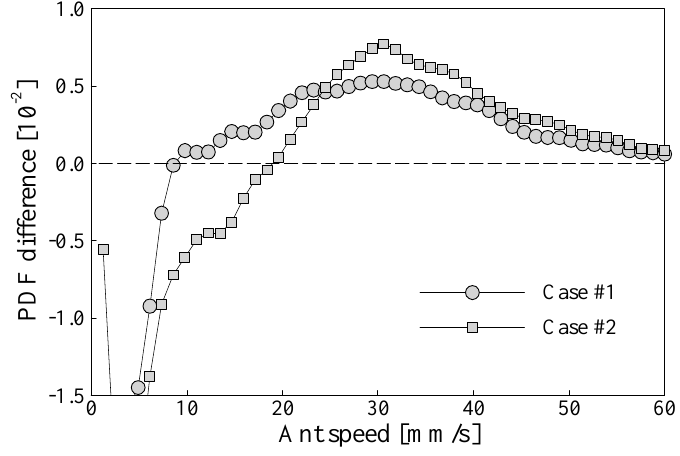
Figure 12. Probability density function differences in two